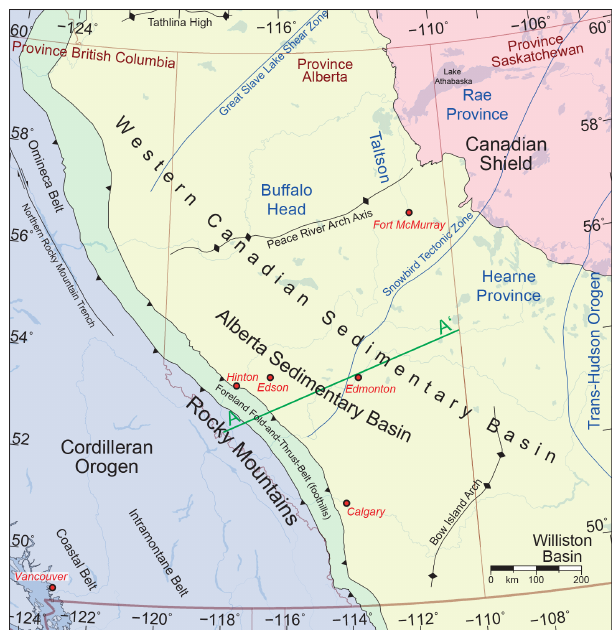
Figure 2. Tectonic map of Alberta and surroundings displaying the important structural features. Blue lines and labels indicate Precam- brian structures in the basement. Provincial boundaries and areas are indicated by reddish-brown colours, and tectonic features are labelled in black. The trace of the cross section in Fig. 3 is indicated by a green line. The map is modified and redrawn after Wright et al.